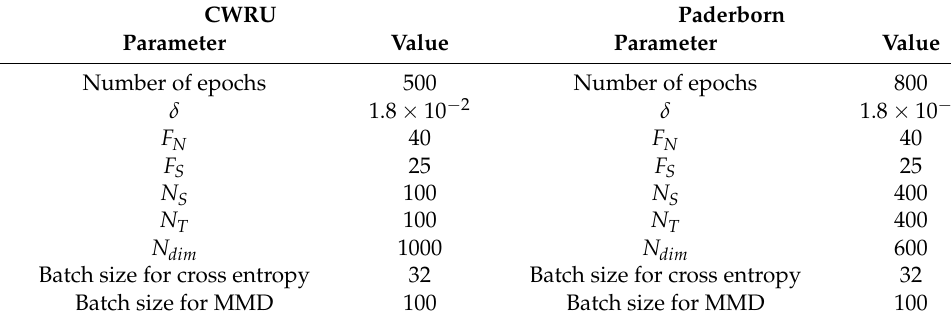
Table 4. Parameter specification in the proposed methodology.